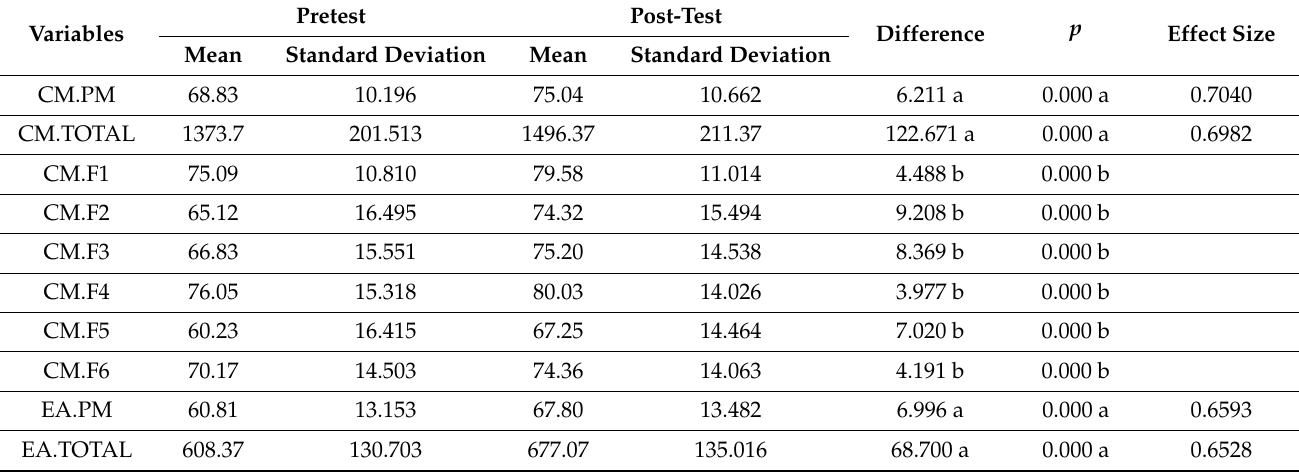
Table 10. Descriptive and contrast measurements of the experimental group in the CM and EA